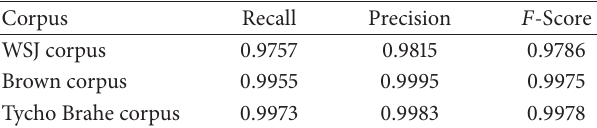
Table 7: Classification results of baseline model.